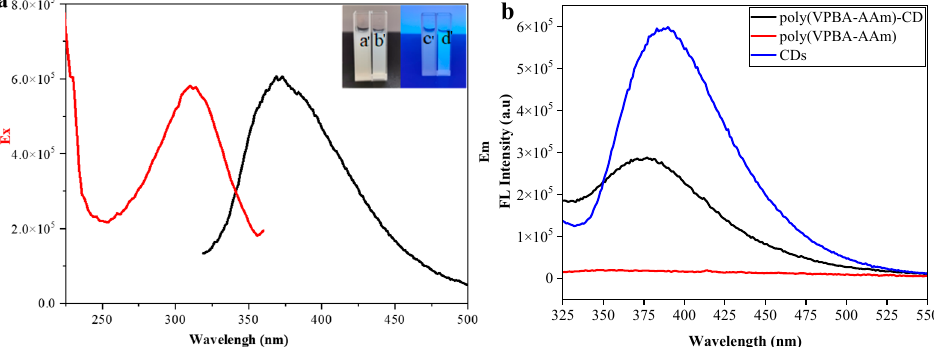
Figure 3. ( a ) Fluorescence spectra of poly(VPBA ‐ AAm) ‐ CD: the insets are the photographs of poly(VPBA ‐ AAm) ‐ CD and poly(VPBA ‐ AAm) under natural light ( a ’ , b ’ ) and UV light at 365 nm ( c ’ , d ’ ). ( b ) Typical fluorescence spectra of free CDs, poly(VPBA ‐ AAm) microgel and poly(VPBA ‐ AAm) ‐ CDs hybrid microgel, respectively ( λ ex = 310 nm, 20 o C).